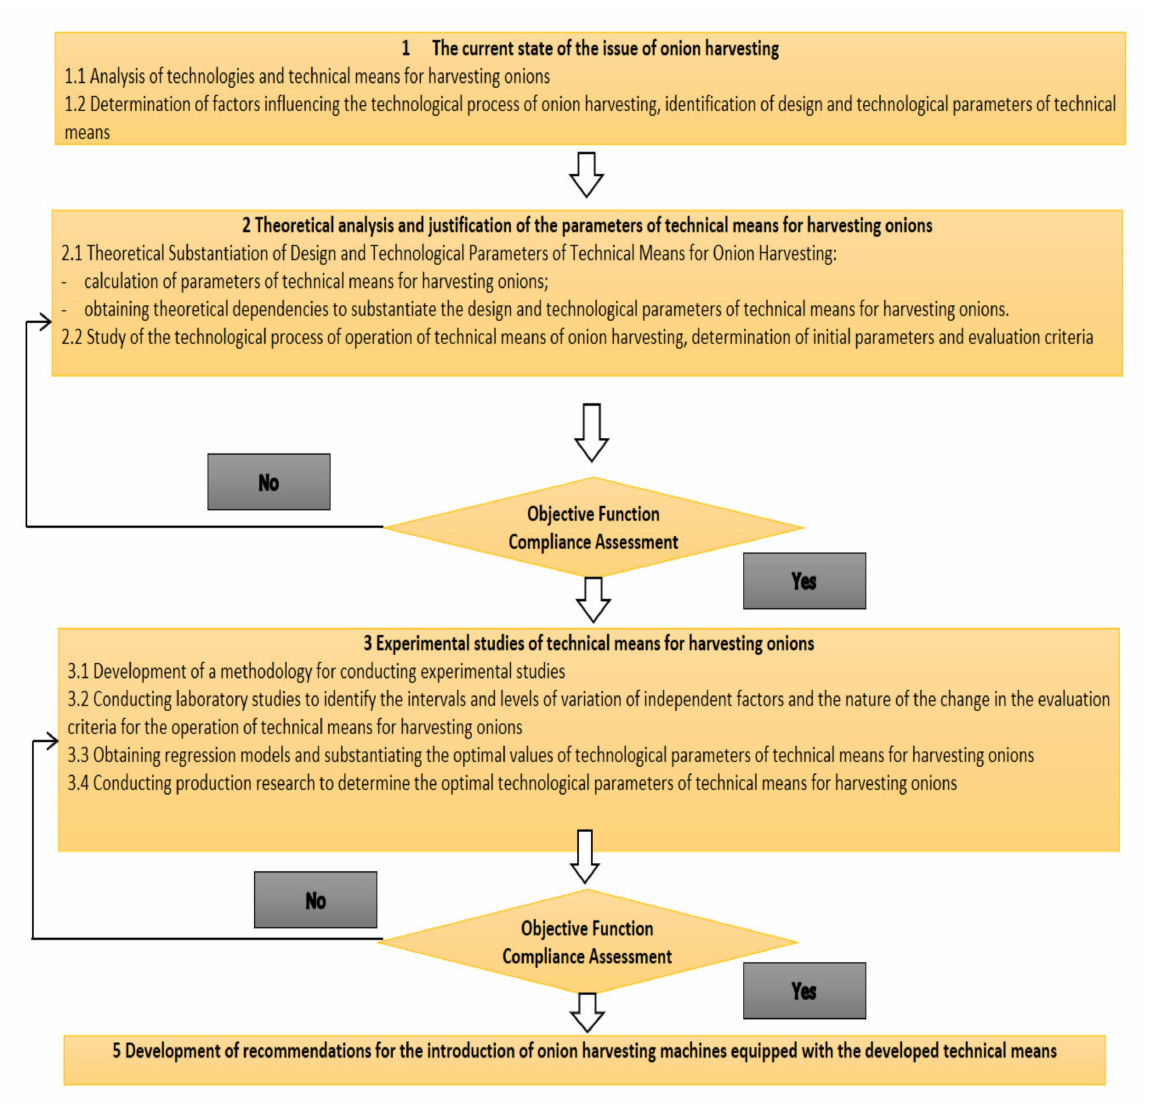
Figure 9. Structural scheme of